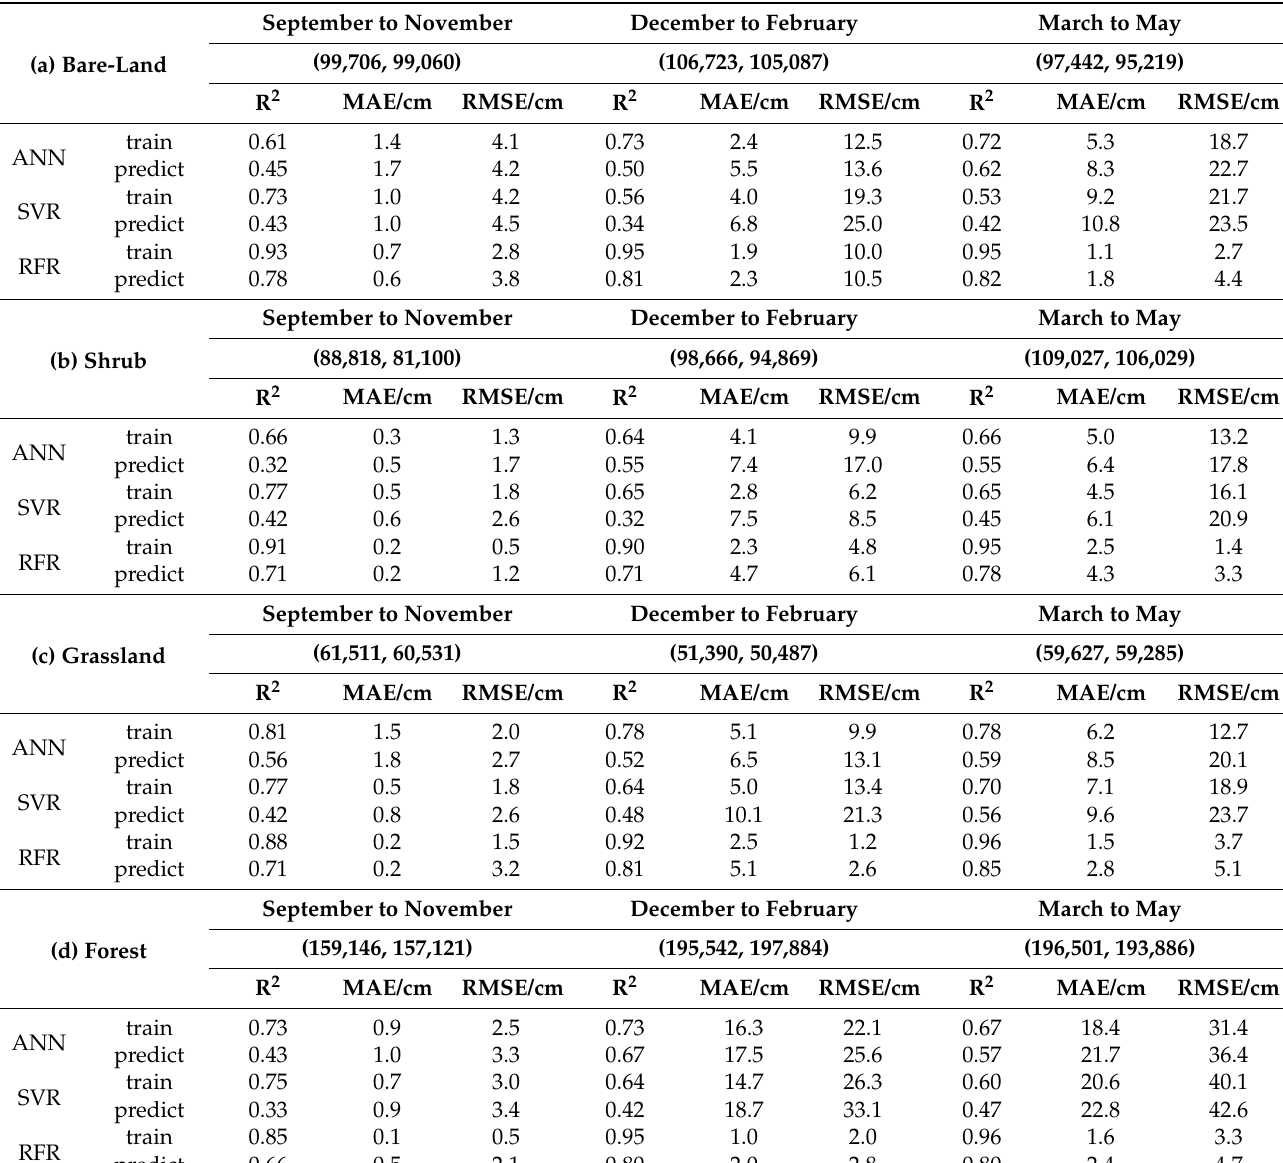
Table 2. The uncertainties of the three models in different land cover types and different seasons. (The coefficient of determination (R 2 ), Mean Absolute Error (MAE), and Root Mean Square Error (RMSE) of three fused snow depth data against in situ observations in different snow stages and different land cover areas.). Note that the two numbers within brackets represent the samples used in training and prediction,